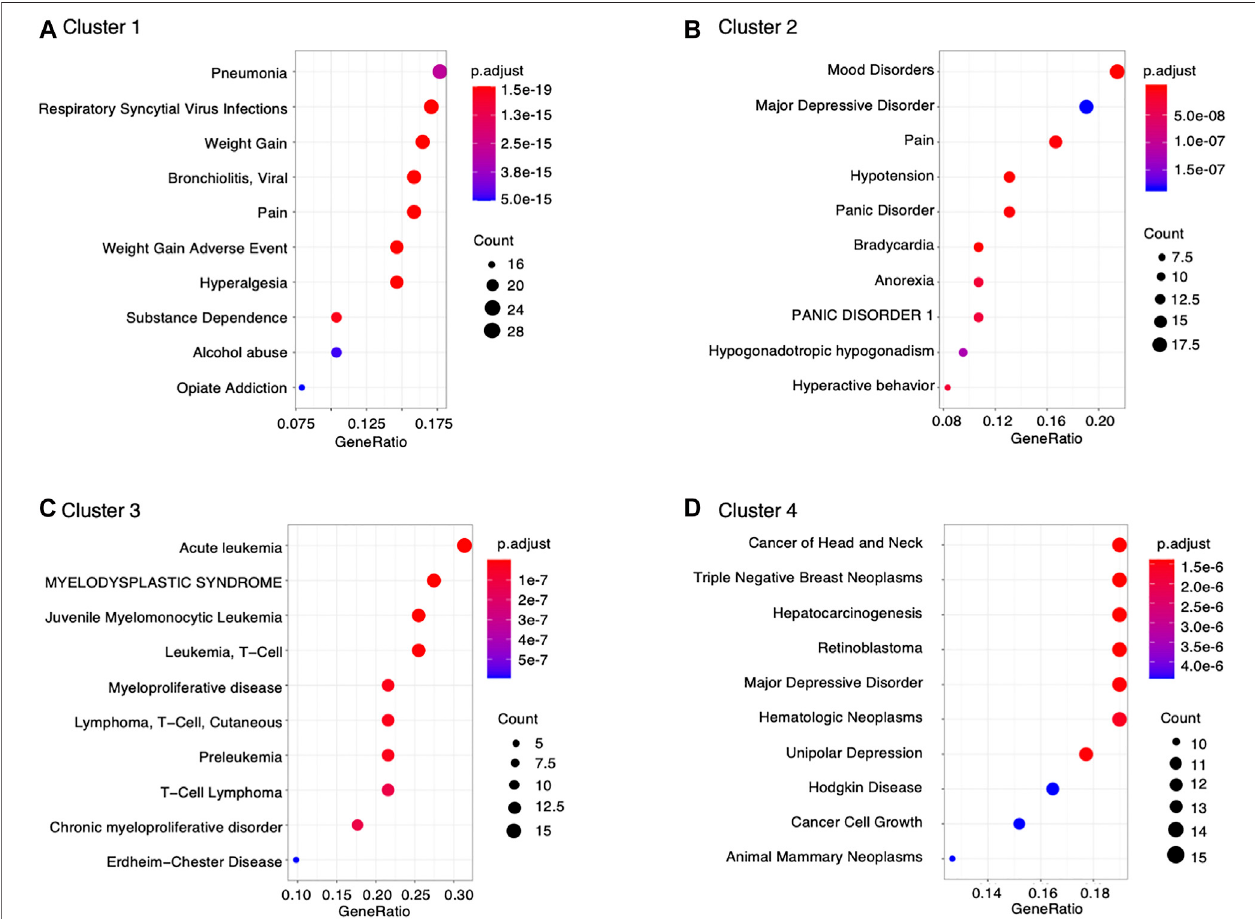
FIGURE 3 | Dot plot of DisGeNET disease enrichment